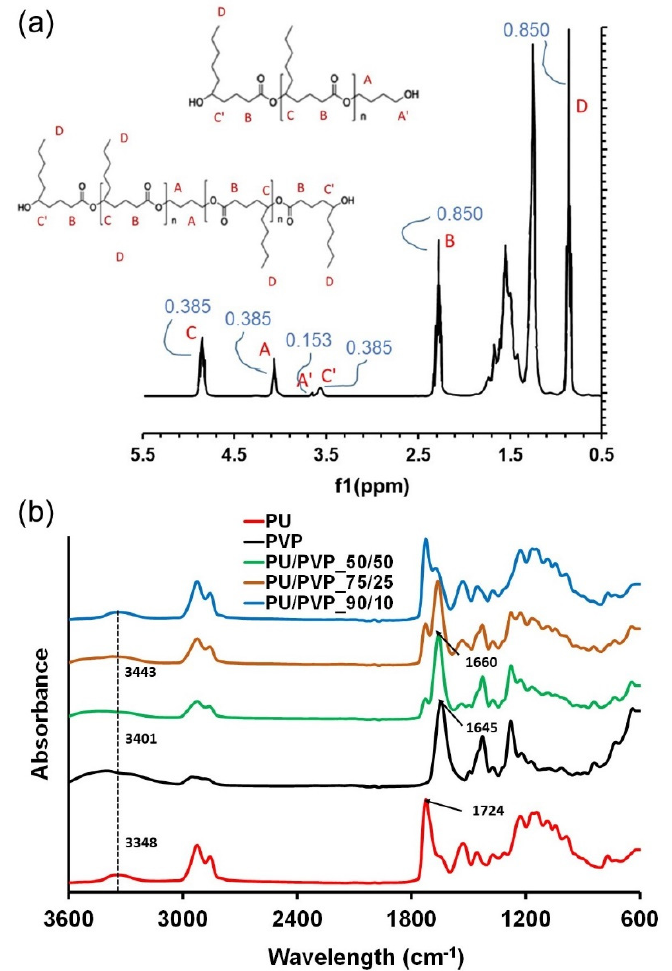
Figure 3. ( a ) 1H ‐ NMR spectrum of the PU polymer structure indicating an aliphatic polyester polyol system based on the ring opening polymerization of 7 ‐ Butyl ‐ 2 ‐ oxepanone type polyol ( b ) FTIR spec ‐ tra of the pure polymers and all the hybrid films shown in Table